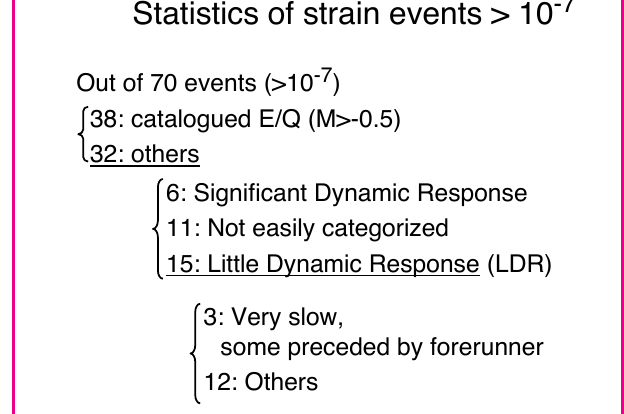
Figure 5. The statistics of the strain events (data after Naoi et al.,